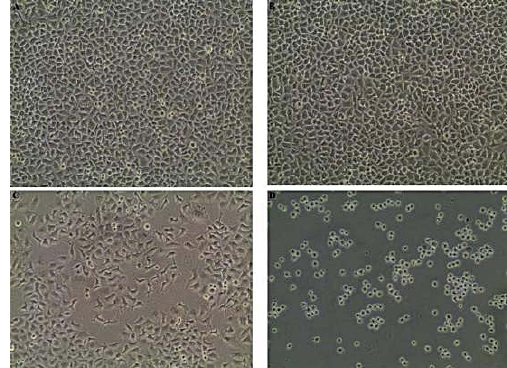
Fig. 6. Phomopsis sp., (A) A549 cell control, (B)